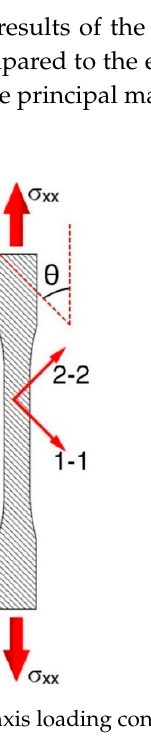
Figure 3. Resulting 3D failure surface for FFF parts produced with acrylonitrile butadiene styrene (ABS) [2].